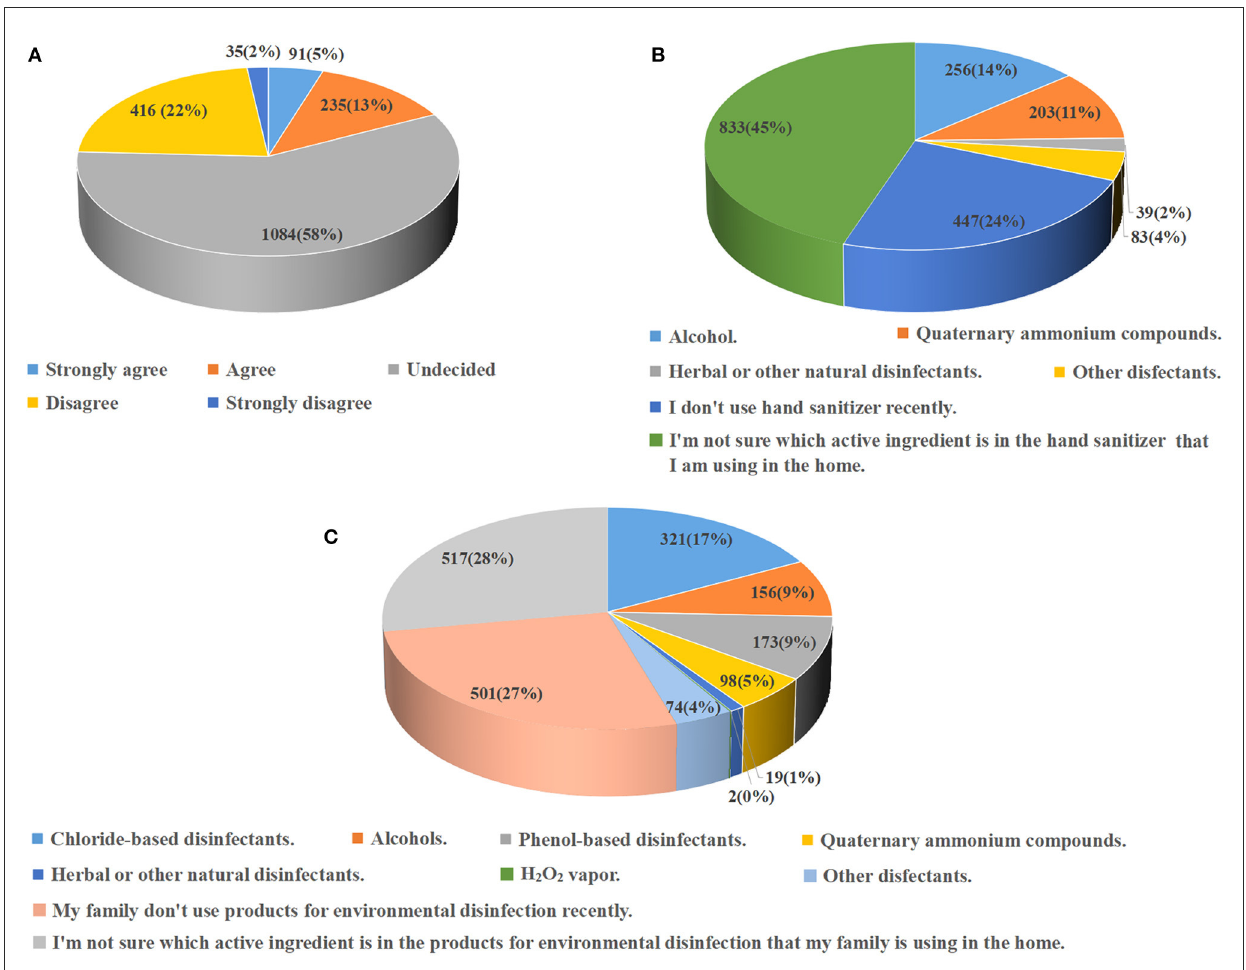
FIGURE1 Practice of Chinese residents to use environmental friendly disinfectants in the household setting under COVID-19 conditions. (A) Participants’ responses to the statement “ when I am choosing household disinfectant products under COVID-19 conditions, I pay special attention to the environmental certification label on the product, and only buy the environmental certified disinfectant products ”. The participants’ perceived core active ingredients in the hand sanitizers (B) and products for environmental disinfection (C) currently used in their home.